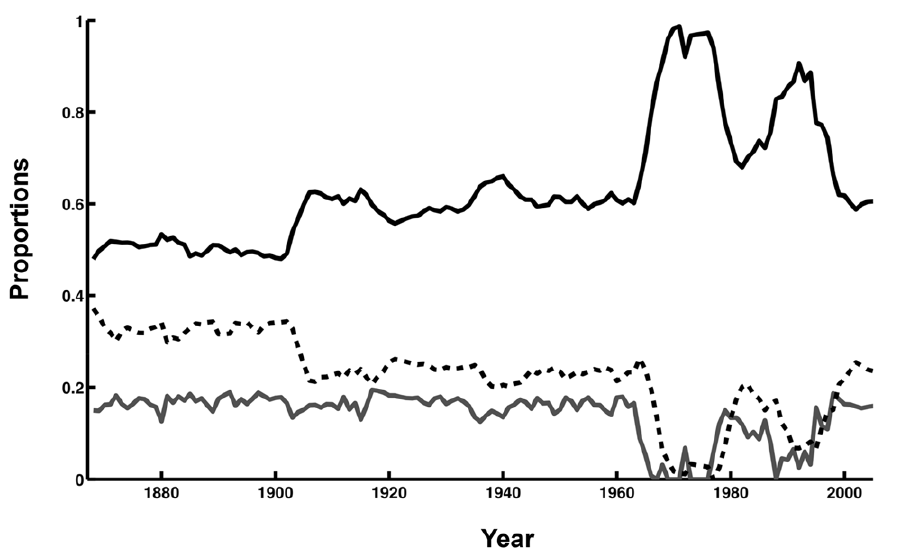
Figure 4. Temporal changes in age structure before pupping of the Caspian seal population. The skewed age structure is mainly due to hunting mortality and, sterility in the 1960s and 1970s. Adults=solid line, sub-adults=dashed line, yearlings=solid grey